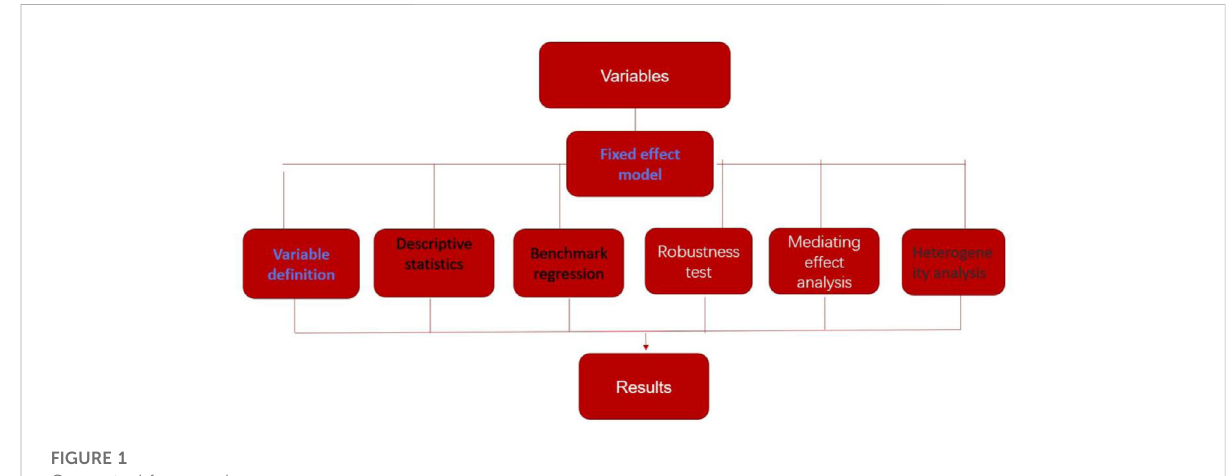
FIGURE 1 Conceptual framework.